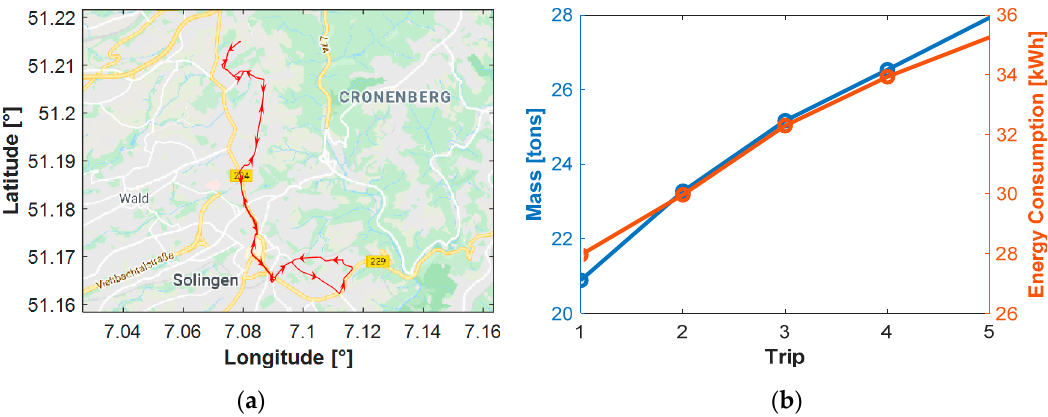
Figure 3. ( a ) Route of first BOB-Line 695 in Solingen, Germany. ( b ) Correlation of mass and consumption for the 695 route.